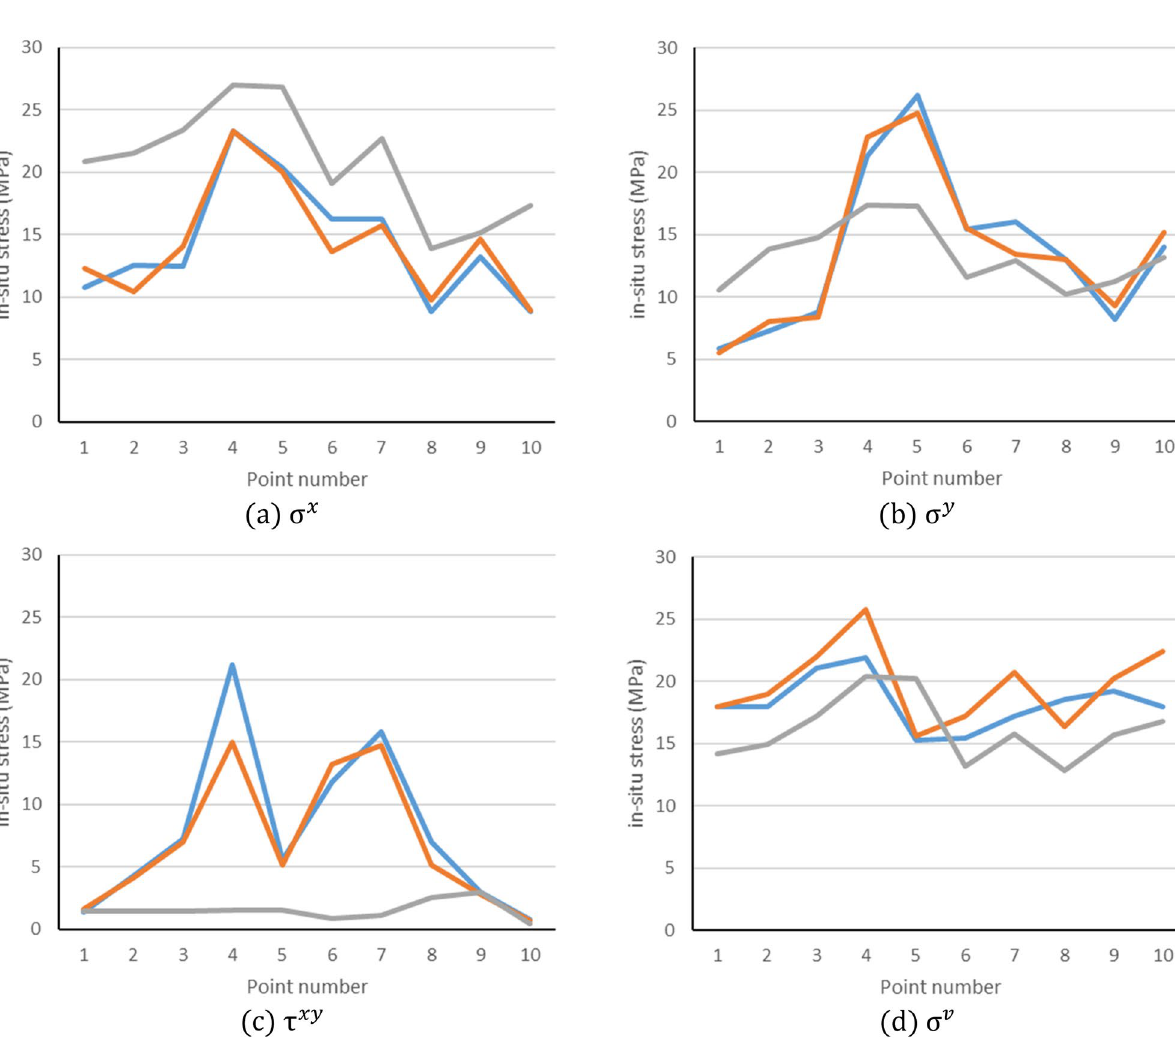
Figure 7. Diagram of comparison between simulated and measured